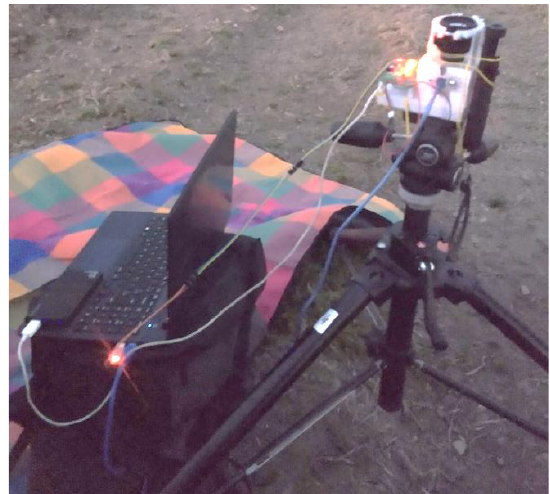
Figure 8. Breadboard connected to the computer and positioned for the observations.